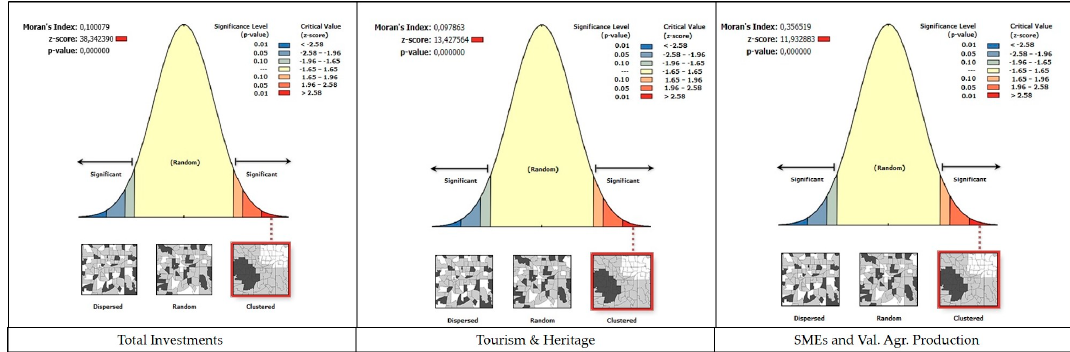
Figure 4. Global Moran’s I of LEADER Approach (2000–2013).